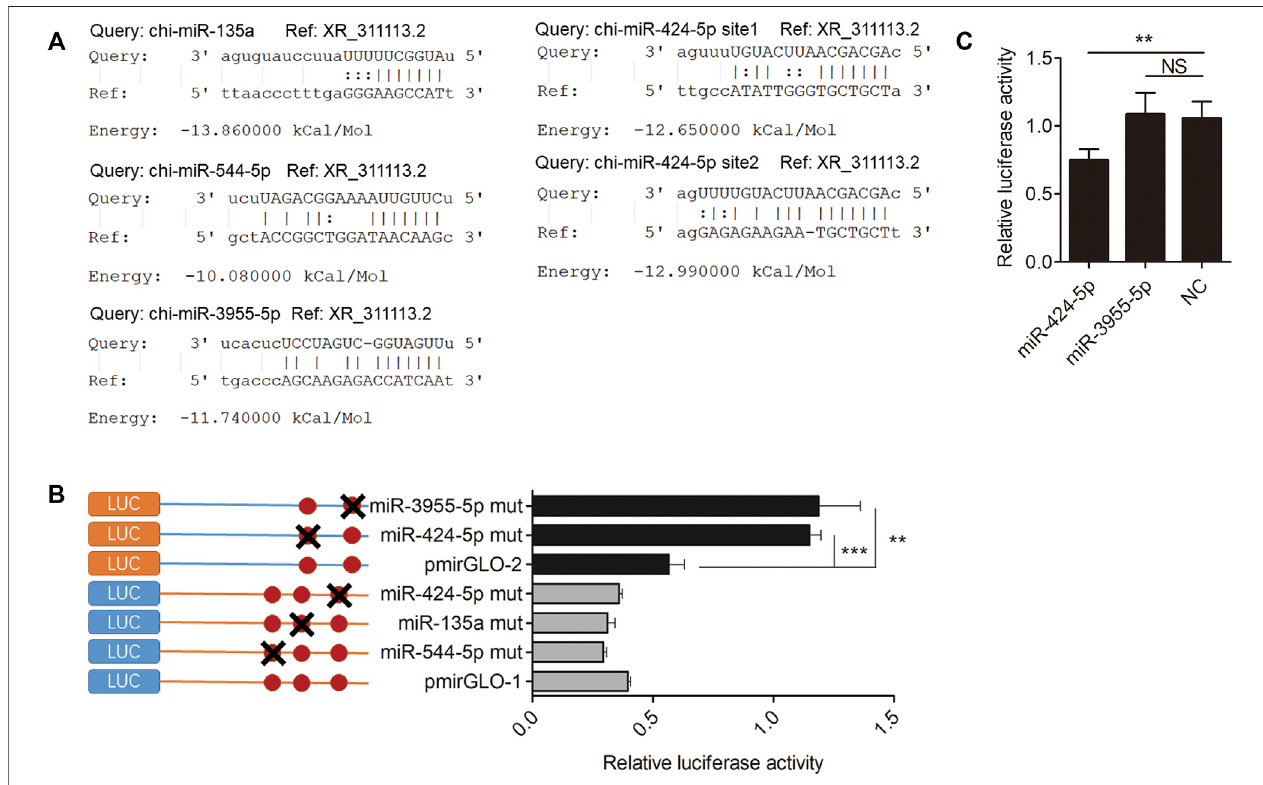
FIGURE5| XR_311113.2servesasaspongeforchi-miR-424-5p. (A) Alignmentofpotentialchi-miR-135a,chi-miR-424-5p,chi-miR-544-5p,andchi-miR-3955- 5pbasepairingwithXR_311113.2,asidenti fi edbythemiRandasoftware. (B) TheluciferaseactivityofmiRNAbindingsitesmutantpmirGLOvectorbyluciferaseassayin GKcells.Site-directedmutagenesisinthechi-miR-135a,chi-miR-424-5p,chi-miR-544-5p,andchi-miR-3955-5pbindingsiteoftheXR_311113.2.ThepmirGLO-1and pmirGLO-2 were wild vector of XR_311113.2. (C) Luciferase reporter assay to determine the luciferase activity of pmirGLO-2 in GK cells transfected with chi-miR- 424-5p and chi-miR-3955-5p mimics, to identify miRNAs that bound to the XR_311113.2 sequence. ** p < 0.01; *** p < 0.001; NS, not signi fi